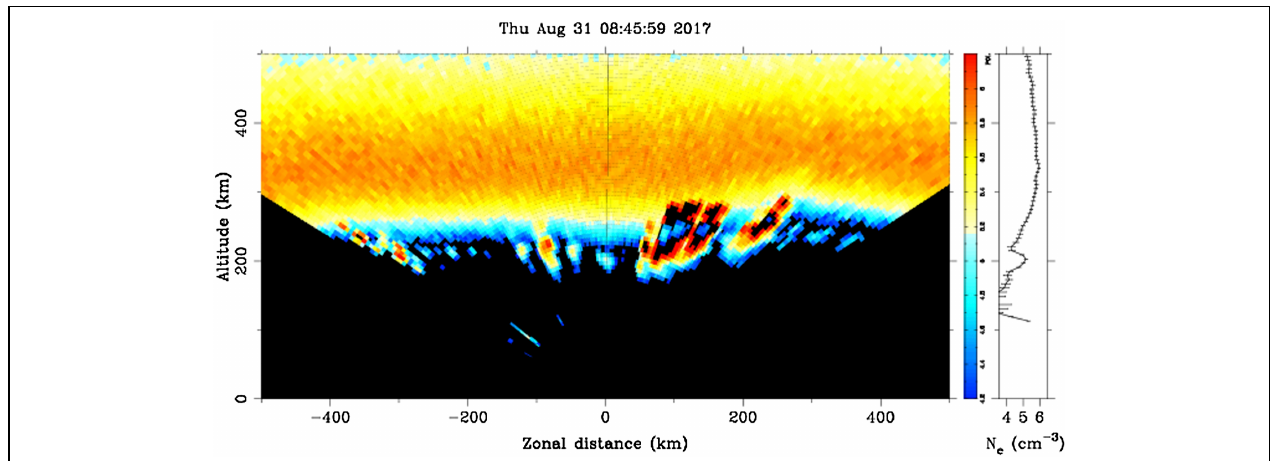
FIGURE 2 | ALTAIR radar images showing bottom-type layers at the base of the F region just prior to the onset of ESF. The data were acquired during NASA project WINDY (Hysell et al., 2020).